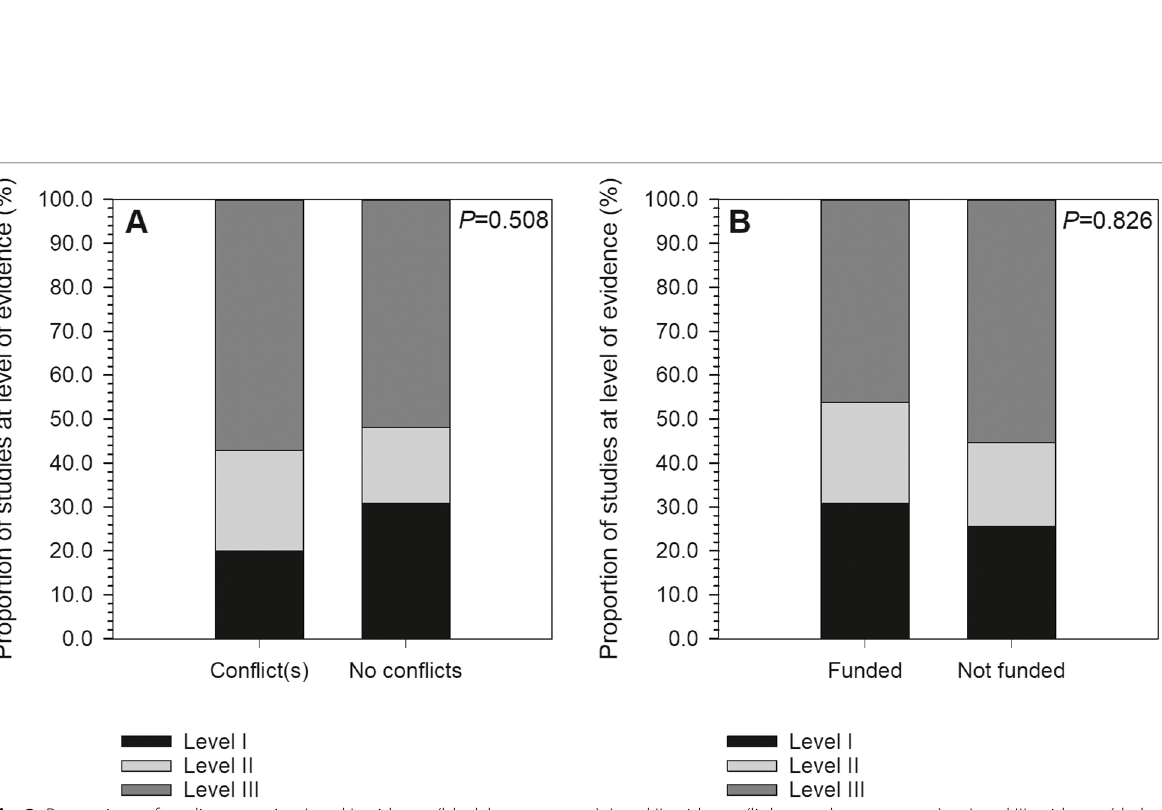
Fig. 3 Proportions of studies reporting Level I evidence (black bar segments), Level II evidence (light gray bar segments) or Level III evidence (dark gray bar segments). Studies were compared for ( A ) any reported conflicts of interest vs . no reported conflicts of interest, and ( B ) any reported industry funding vs . no reported industry funding. Neither comparison found significant between-groups